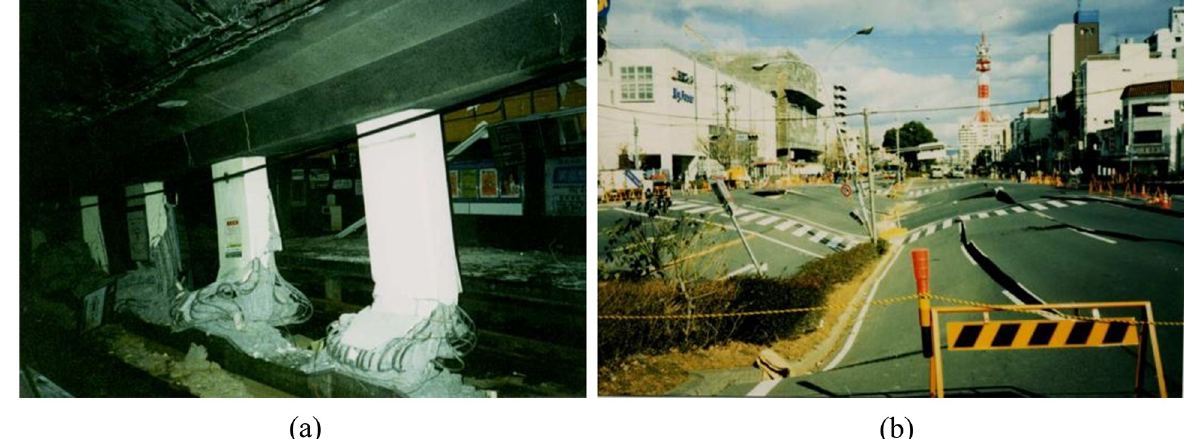
Fig 1. Damage to the Daikai station in the Kobe earthquake [2]. (a) Failure of center columns and collapsed roof, (b) Substantial surface settlement caused by the collapse of the Daikai station underneath.